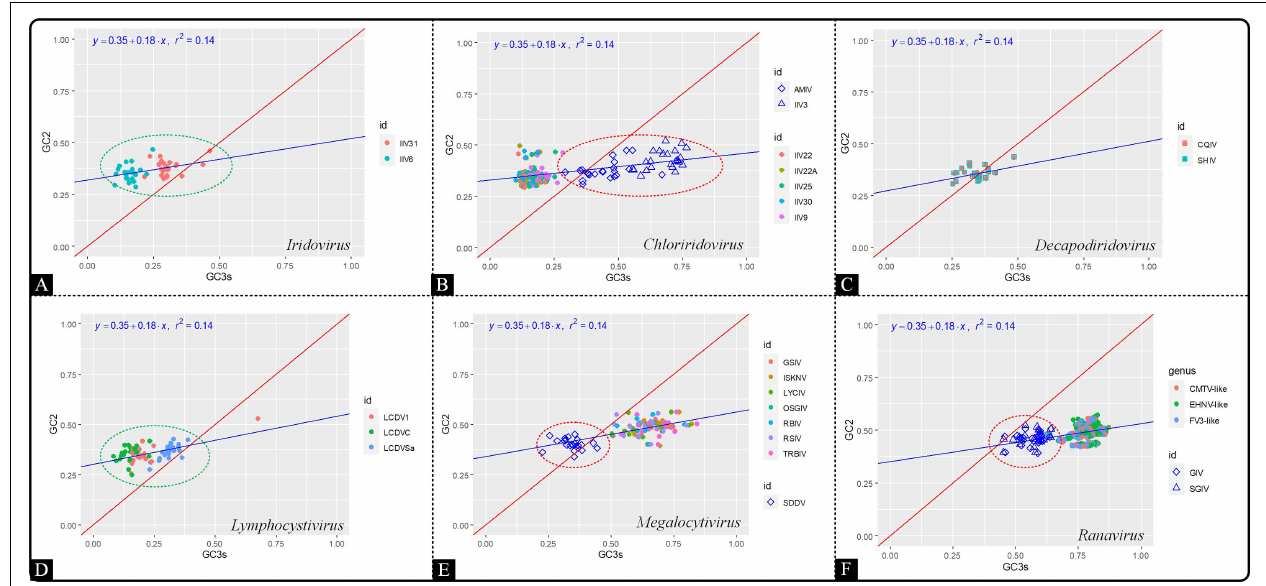
FIGURE 6 | Neutrality plot analysis based on GC12 against GC3 of 53 Iridoviridae viruses. The blue line is the linear regression of GC12 against GC3 ( r 2 = 0.14). Green circles suggest a high dispersion degree among points inside the circle, while red circles indicate that points inside the circle have a high degree of dispersion as compared to those outside the circle. (A) Iridovirus , (B) Chloriridovirus , (C) Decapodiridovirus , (D) Lymphocystivirus , (E) Megalocytivirus , and (F) Ranavirus.